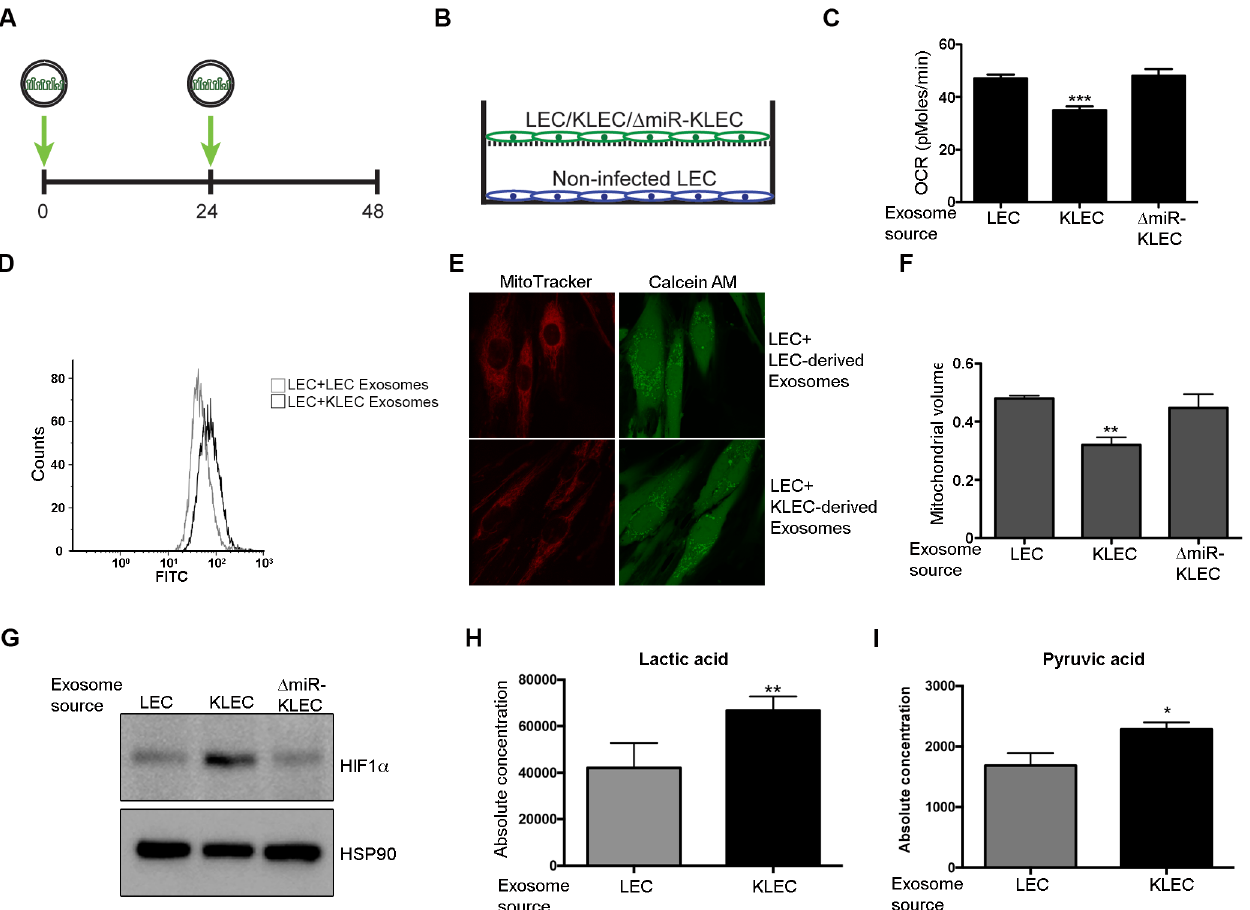
Fig 3. KLEC-derived exosomes induce the reverseWarburg effect. (A-B) Schematic illustrationof exosome education. 10 5 non-infected cells were incubatedfor total of 48 hours when 2.5x10 9 exosomes were added every 24 hours (A) or co-cultured for 5 days with 10 5 of the indicatedcell in Transwellplates (B). (C-G) 10 5 cells were educatedusing 2.5x10 9 of the indicatedexosomes and analysedfor the followingmetrics: (C) Oxygen consumptionrate (OCR) as measuredusing the Seahorse XF24 Analyser. Cells were seededat a density of 4x104 cells per well and the assay was performed accordingto the manufacturer’s Mito stress protocol. The bar graph presents the averagebase line OCR from 3 independentexperiments relative to non-targeting control OCR (mean+SD, n = 3). (D) Glucose uptake as measuredby uptake of the